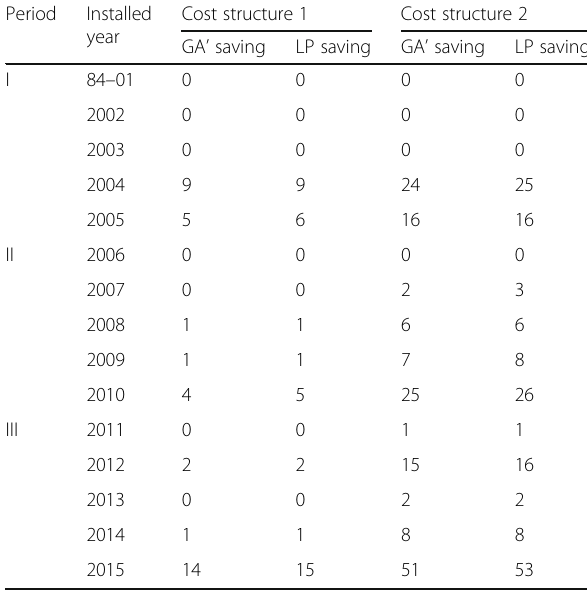
Table 3 Percentage saving of in each cost structure of each year. (Unit: %)